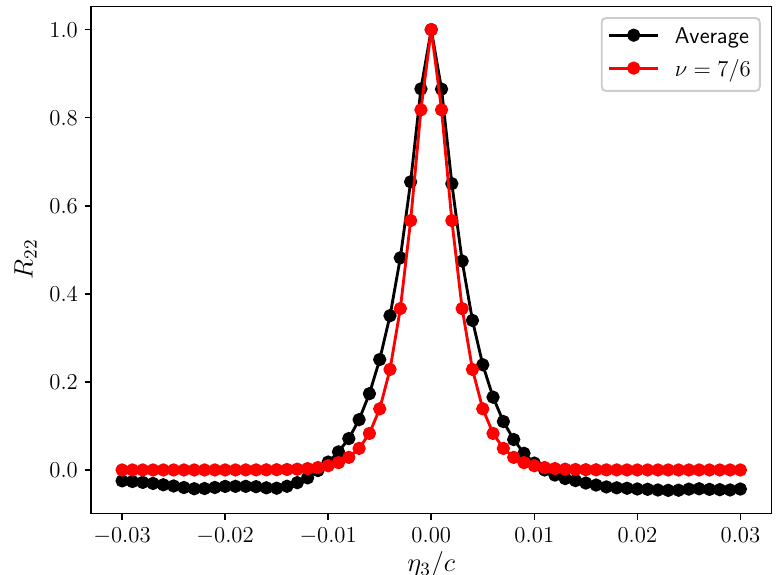
Figure 8. Transverse velocity correlation coefficient—layer 1.